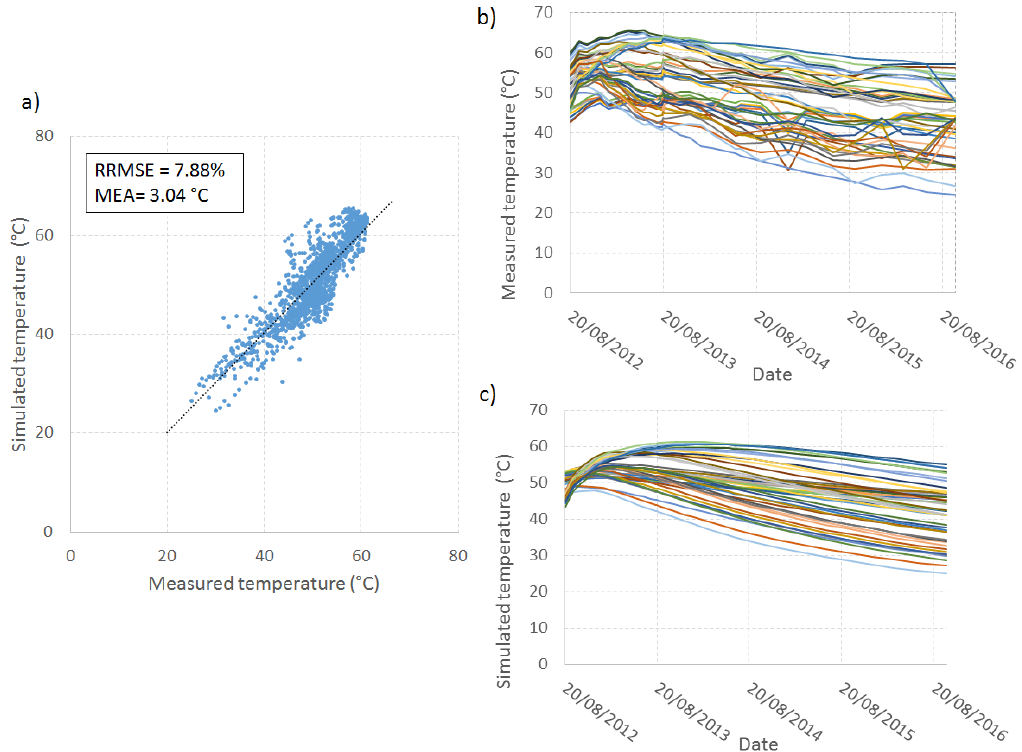
Figure 10. ( a ) Distribution of measured and simulated temperature for the same data points, ( b ) evolution of measured temperature and ( c ) evolution of simulated temperature.